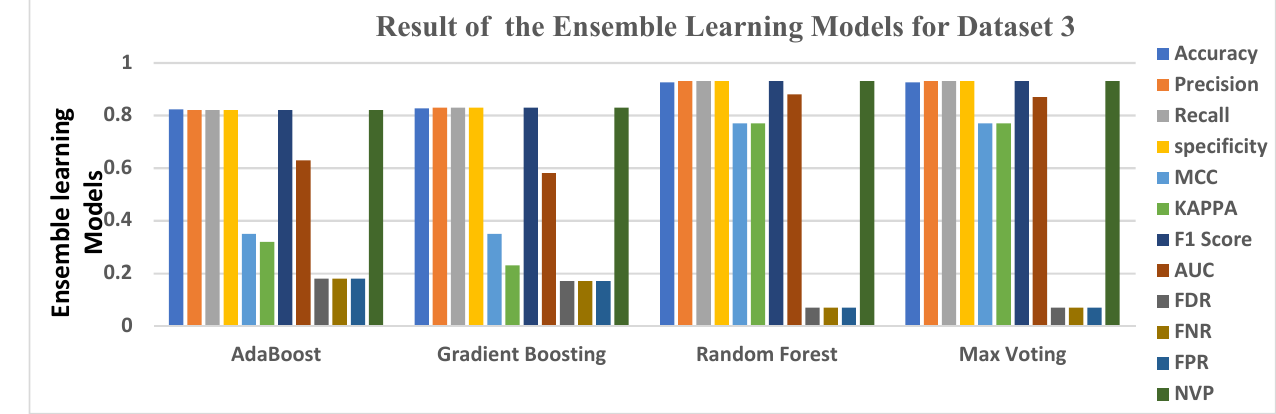
Figure 6. Graphical representation of Evaluation Metrics against Ensemble Learning Models for Dataset 3.